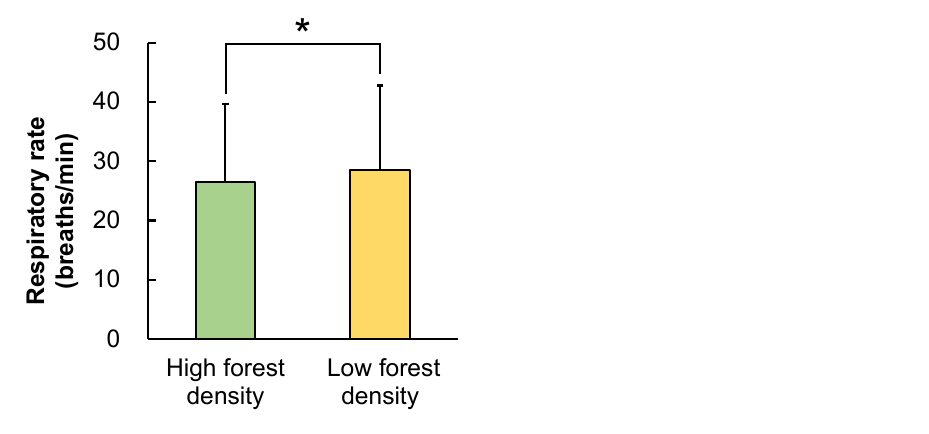
density. N = 17, mean ± standard error. * p < 0.05 using the paired t -test.